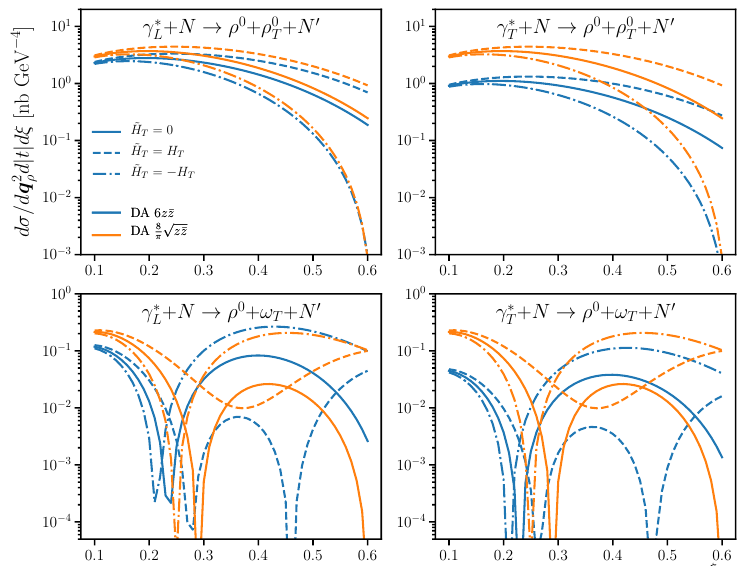
+ ( ρ 0 /ω ) + p cross section for T L T . This process is sensitive to the min